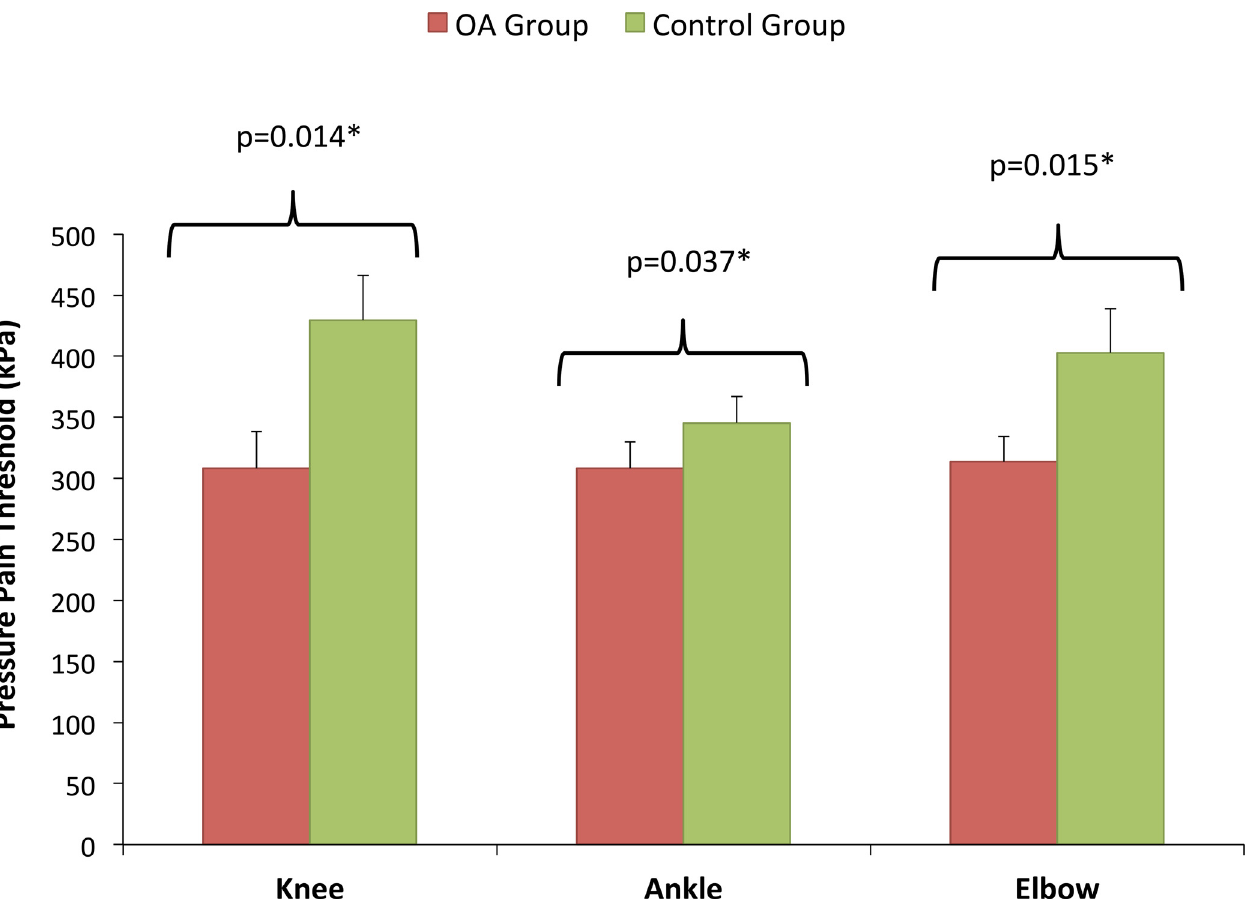
Fig 1. Pressure Pain Threshold. There was a significant difference between OA and Control groups in pressure pain thresholds at both local and distant sites.